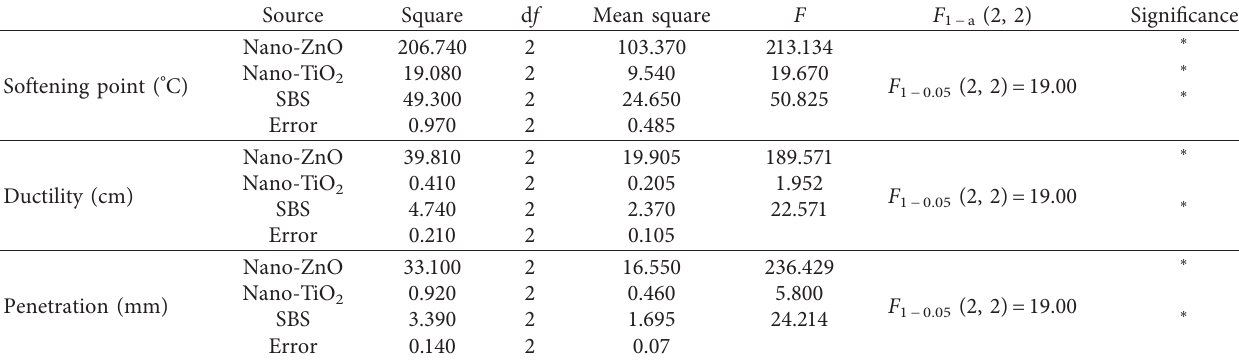
Table 7: Variance analysis of different influencing factors.